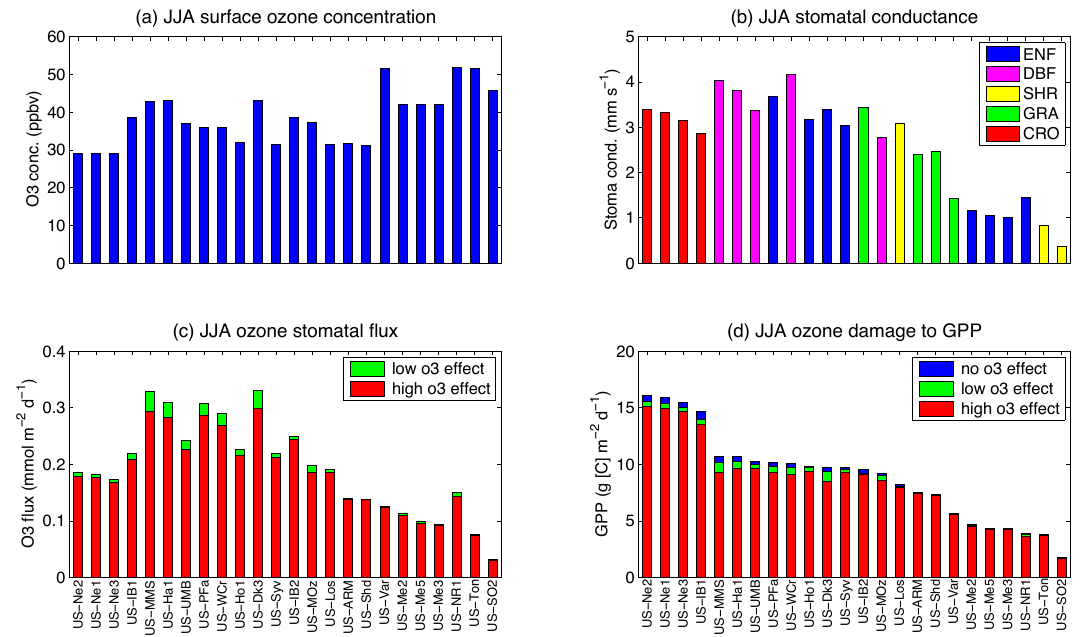
Figure 5. Simulated June–July–August (JJA) summertime average (a) surface [O 3 ], (b) stomatal conductance, (c) ozone stomatal flux, and (d) damages to GPP at different O 3 sensitivity for 24 US sites. The sites are sorted according to the simulated O 3 -free GPP in (d) . For each site, the result represents the average over the period when the site GPP measurements are available during JJA. The land cover definitions are as follows: ENF, evergreen needleleaf forest; DBF, deciduous broadleaf forest; SHR, shrubland; GRA, grasslands; CRO, croplands.